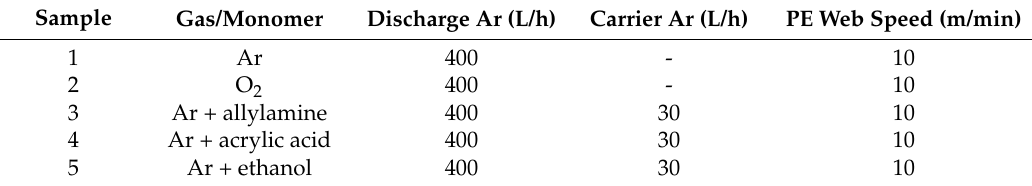
Table 2. The process parameters of DBD plasma